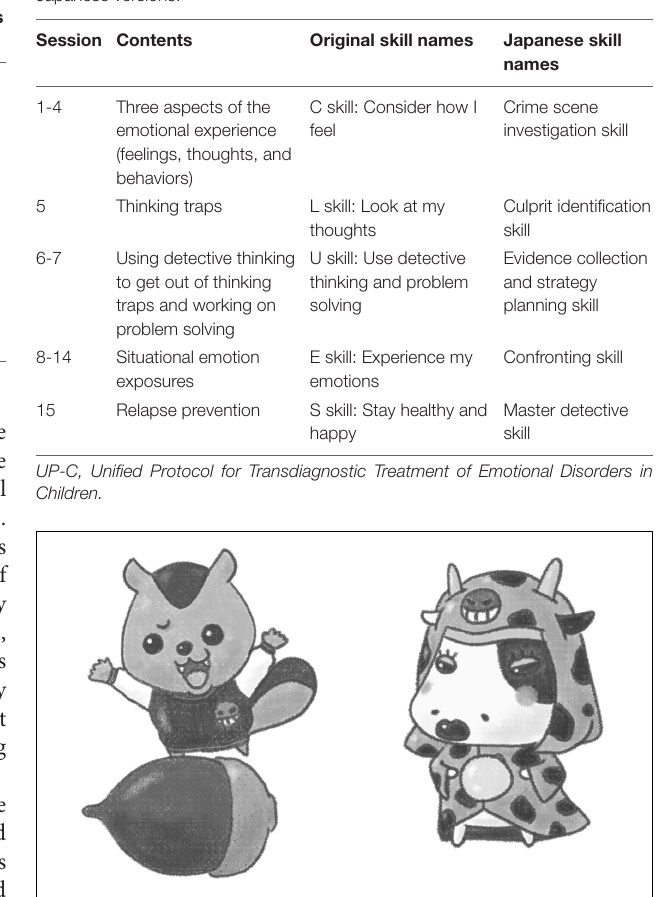
FIGURE 2 | Example of thinking monsters. The monsters represent “jumping to conclusions” (left) and “mind reading” (right). The illustrations were adapted from Ehrenreich-May et al.